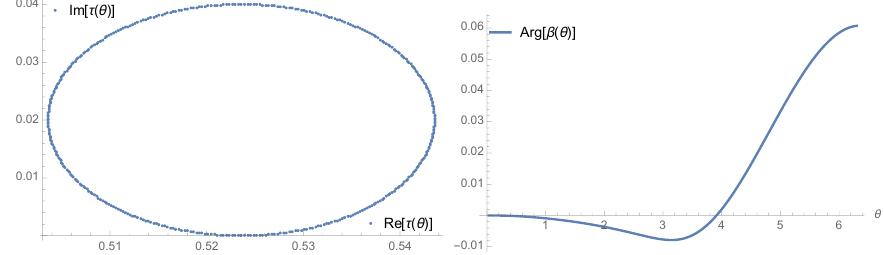
Figure 5 . Plots of the saddle-point equation (cid:15) (cid:12) , for (cid:15) L = 10 (cid:0) 1 ; (cid:15) H = 6 (cid:12) thermal ( ) (grey line); right: for (cid:28) > (cid:12) thermal , the dominant saddle is replaced by a (cid:28) -dependent E new one.